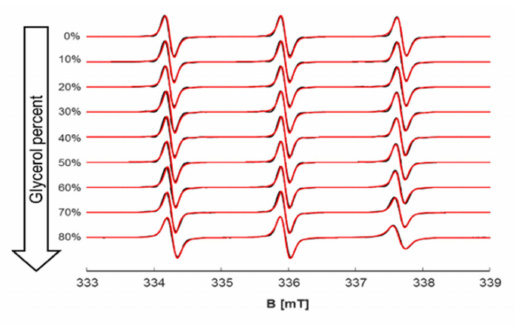
Figure 4. Experimental (black) and simulated (red) X-band CW EPR spectra of 200 µ M TEMPO dissolved in 10 mM citrate bu ff er at di ff erent glycerol contents. Increasing the viscosity results in much slower rotational correlation times and line broadening.